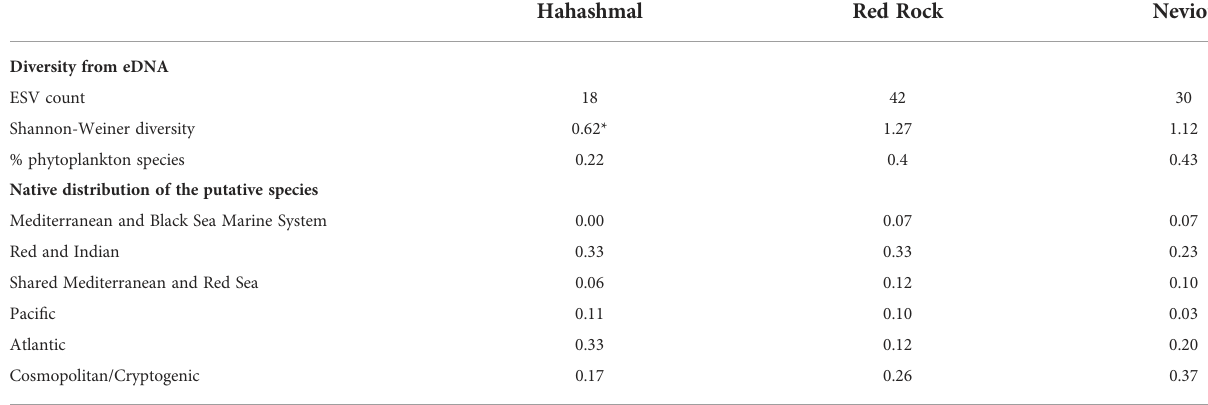
TABLE 3 Characteristics of the communities detected from eDNA in the sampling sites considered.